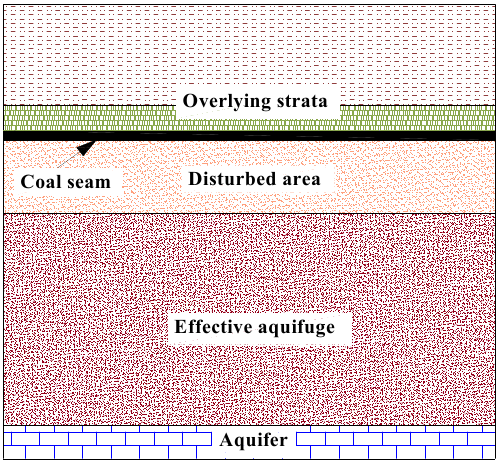
Figure 13. The geometric model.